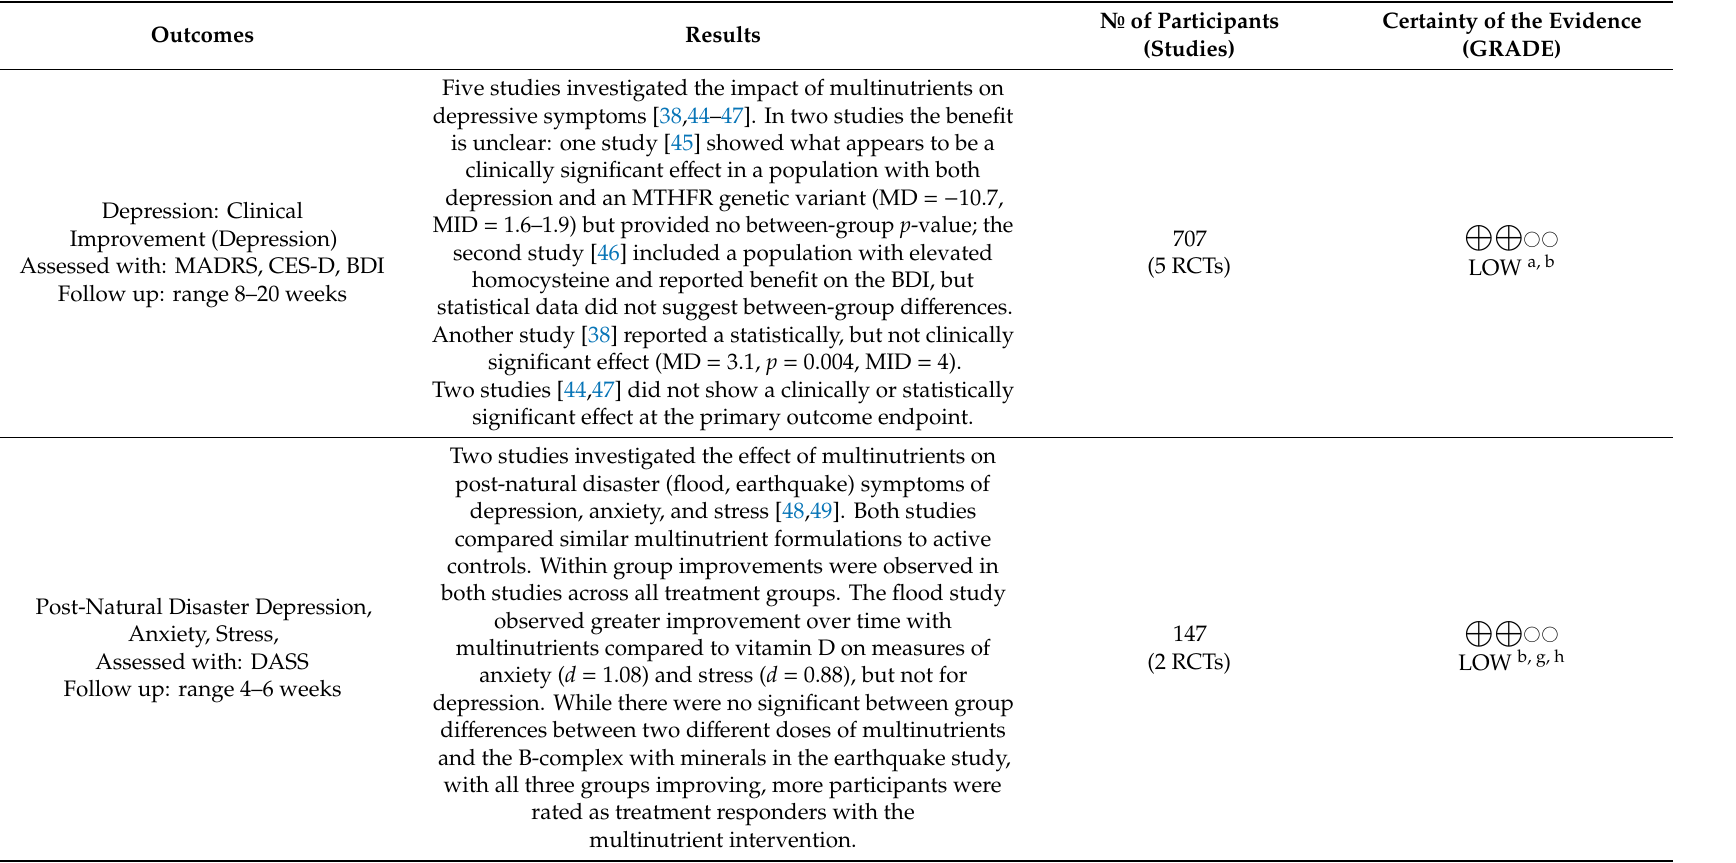
Table 2. GRADE-summary of